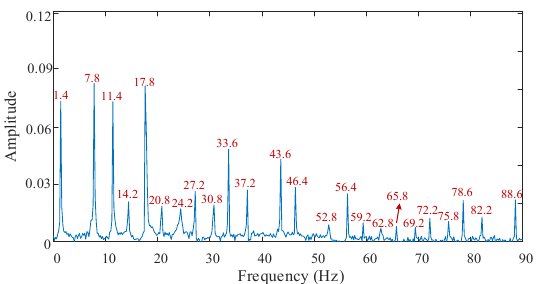
( b ) Figure 6. The finite element analysis model; ( a ) the distribution of magnetic density and magnetic force line during normal operation; ( b ) the distribution of magnetic density and magnetic force line